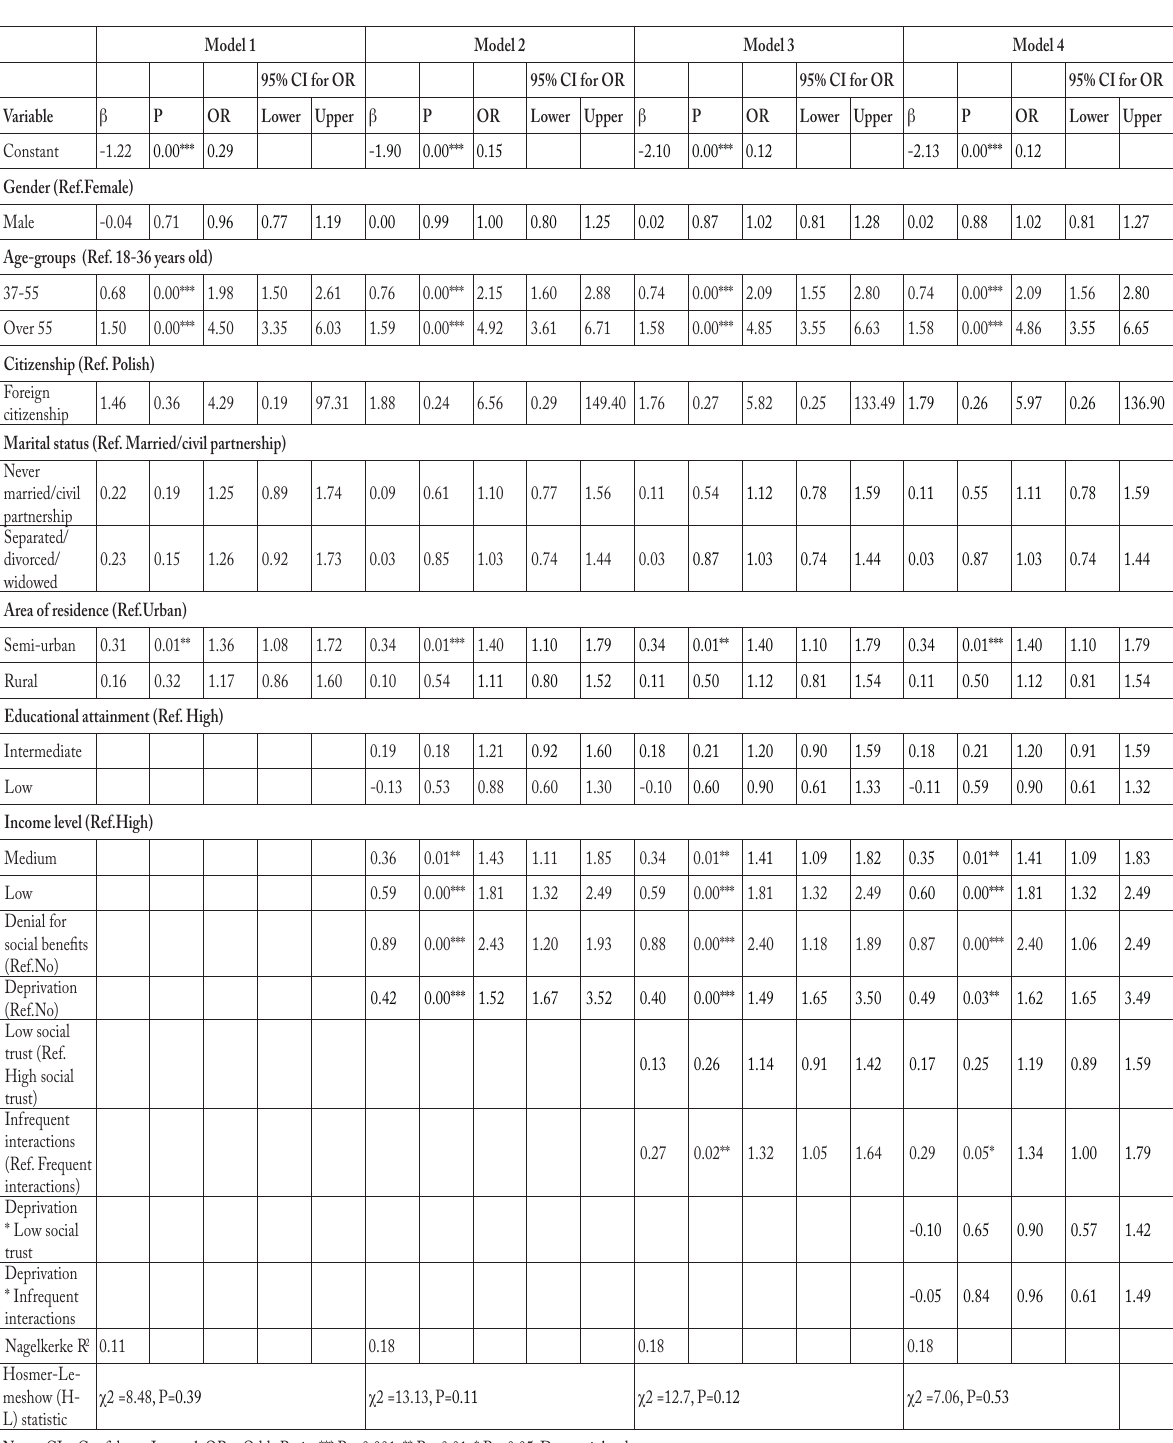
Table 4. Binary logistic regression analysis for predicting poor self-rated health in Poland ( n =